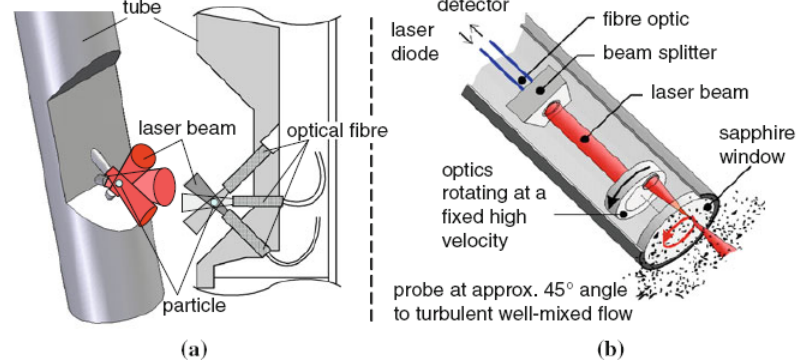
Figure 8. ( a ) Design of the fiber optical FBR sensor: 3D drawing of the tip of the probe ( left ) and the cross-section of the probe ( right ); ( b ) A FBRM probe using light back scattering effects for drop sizing [99].